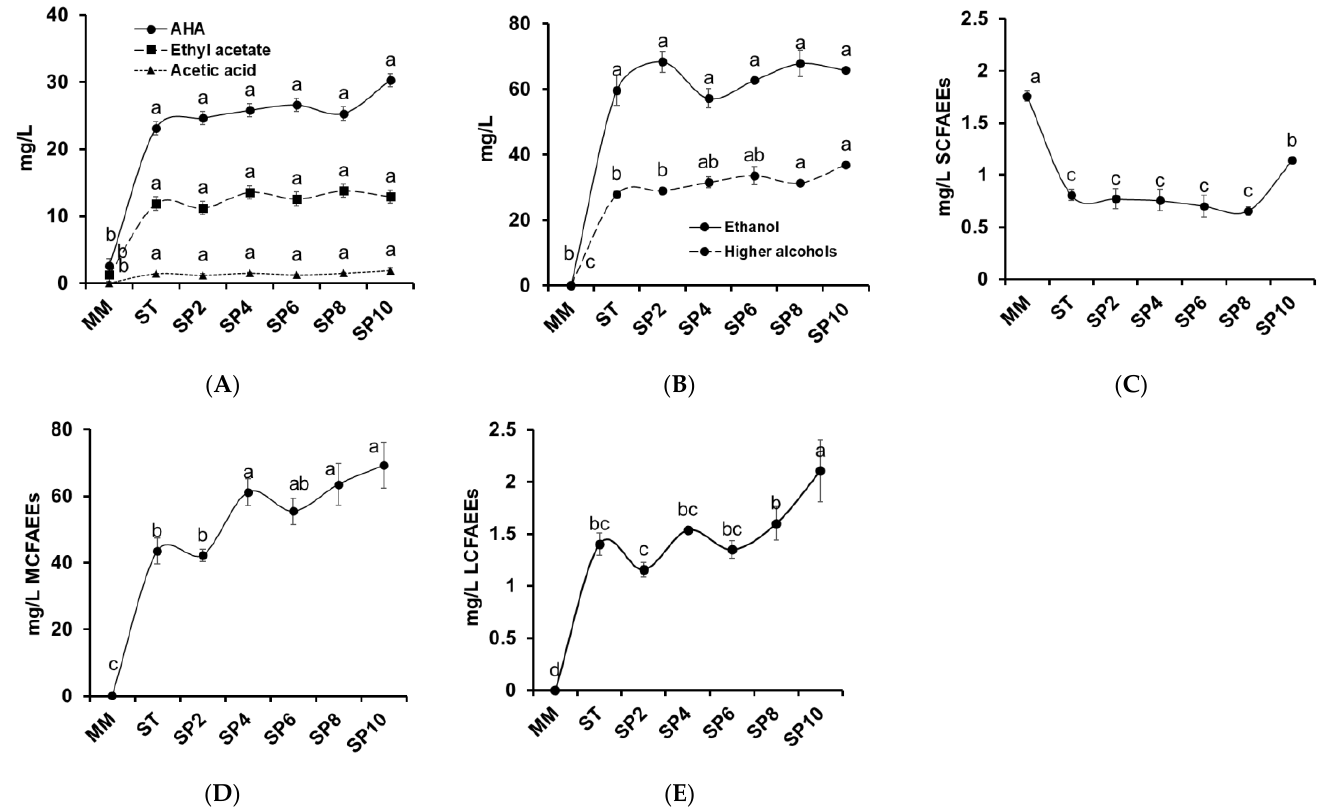
Figure 2. Evolution of aroma volatiles for enriched must, still wine, and during the sparkling process of melon-based wine (10 weeks). Must (MM); Still wine (ST); Sparkling wine (SP) in weeks (2, 4, 6, 8, and 10). ( A ) Acetate higher alcohol (AHA), ethyl acetate and acetic acid. ( B ) Ethanol and higher alcohols. ( C ) Short-chain fatty acid ethyl ester (SCFAEEs). ( D ) Medium-chain fatty acid ethyl ester (MCFAEEs). ( E ) Long-chain fatty acid ethyl ester (LCFAEEs). Different letters in the same image indicate significant differences ( p <